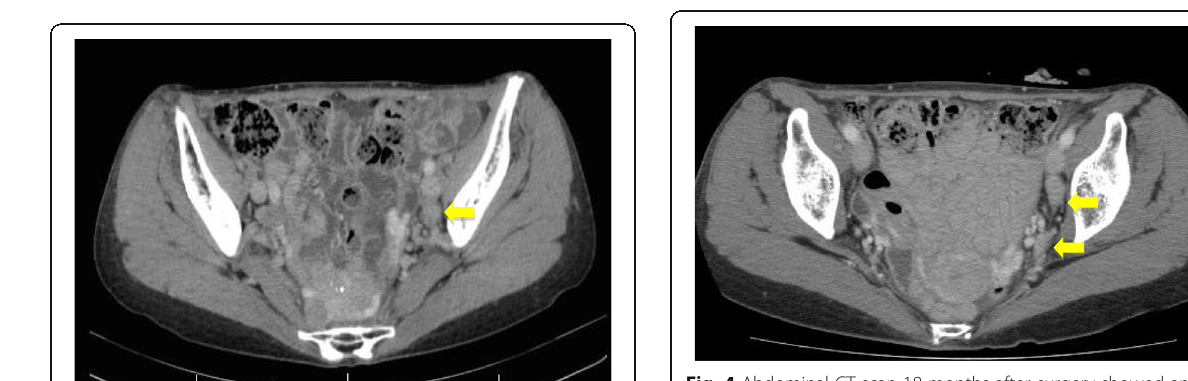
Fig. 4 Abdominal CT scan 18 months after surgery showed an enlarged lymph node at the left external and internal iliac regions